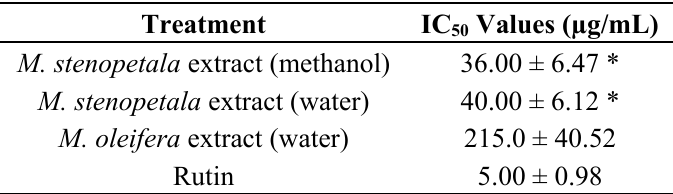
Table 1. Antioxidant effects of crude leaves extracts of M. stenopetala and M. oleifera . IC 50 values for the extract along with the standard rutin are shown. Data are means and SEM values from four separate